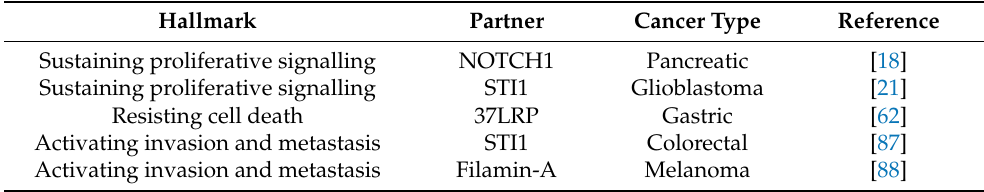
Table 1. Summary of the binding partners involved in the PrP C contribution to a given hallmark of cancer, in relation with the cancer type.